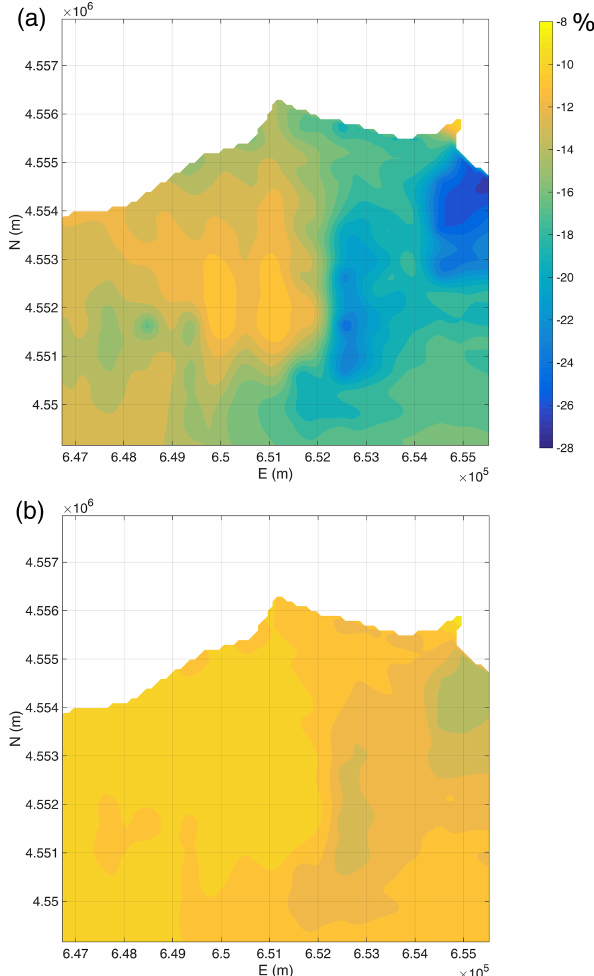
Figure 11. Relative percentage of error in the flow velocity magni- tude for different numbers of fractures: (a) n f = 4; (b) n f =